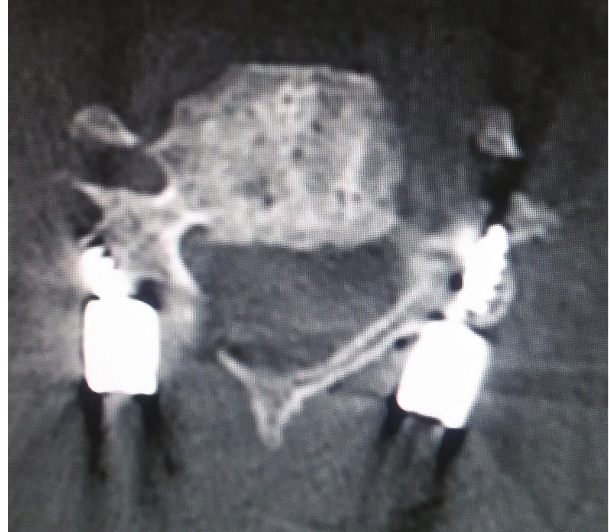
Figure 3. X-ray spine after traction showing realignment of the posterior and the spino-laminar